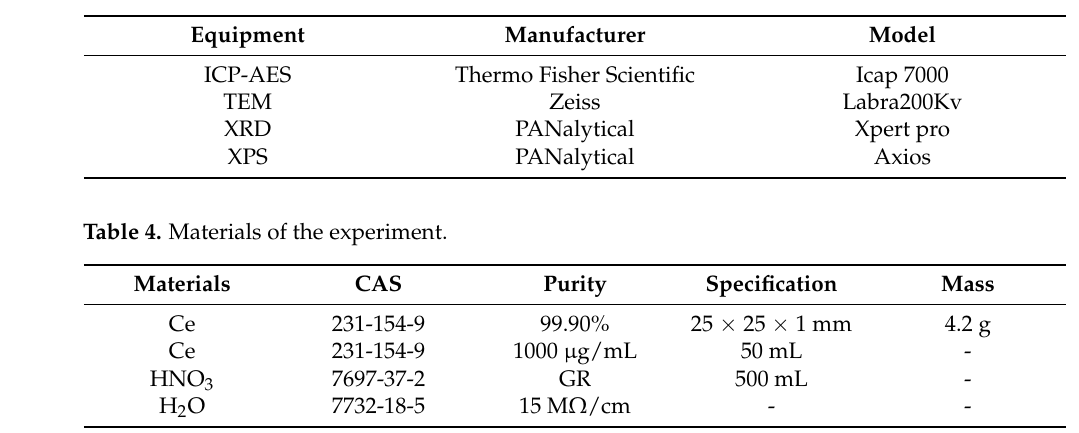
Table 3. The manufacturer and model of equipment.